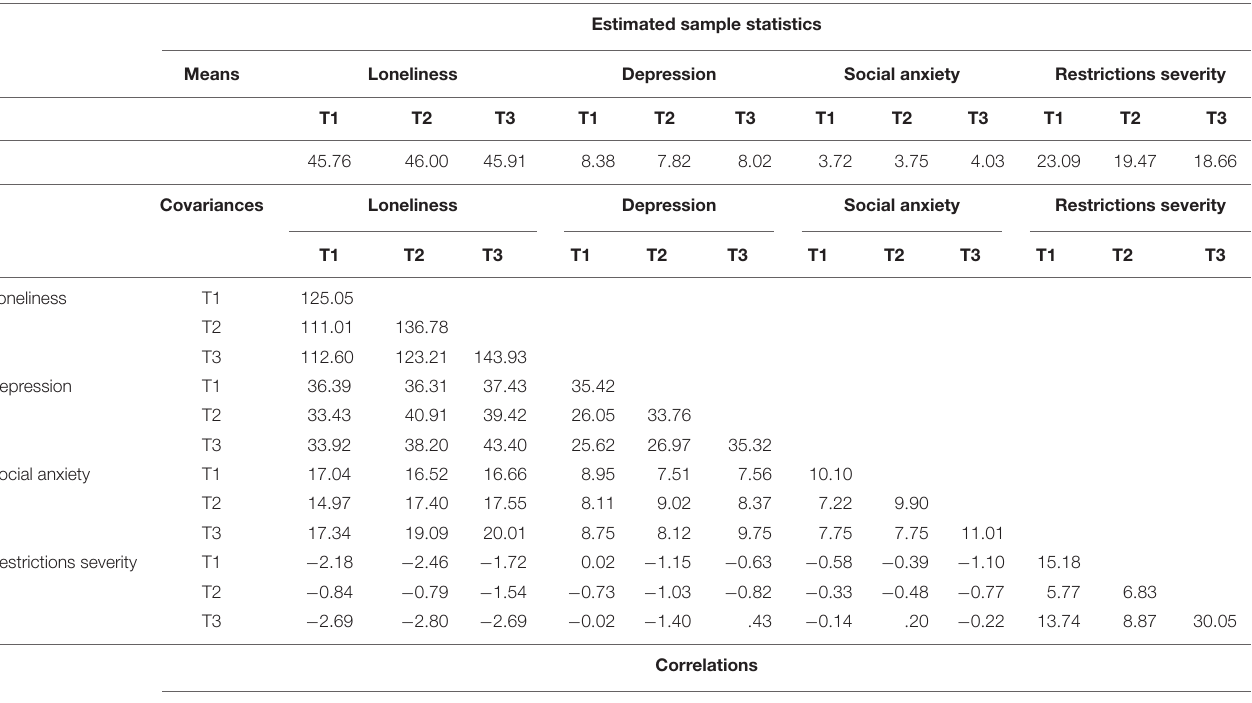
TABLE 2 | Estimated sample statistics for Model 1b: covariances, correlations, and change in loneliness, depression, social anxiety, and SARS-CoV-2 social restrictions. Estimated sample